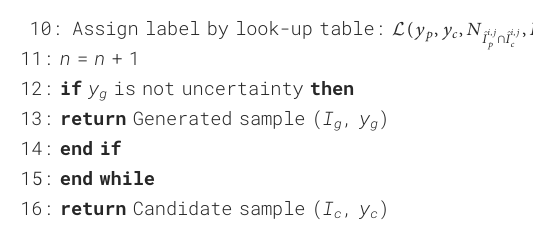
Algorithm 1. Category-Variant Image